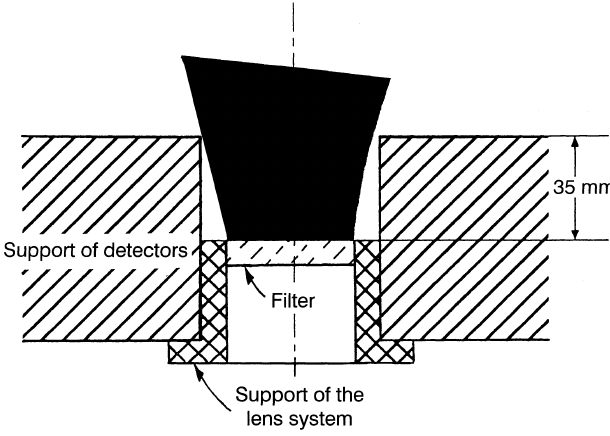
Fig. 8. Schematic diagram (not in scale) of the sink-positioned detector and cone-acceptance of the scattered beams emanating from the sampling